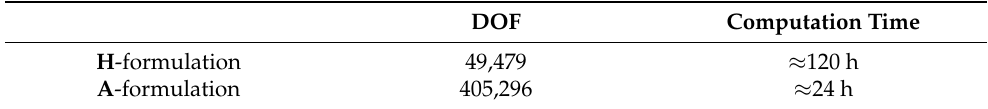
Table 1. Comparison of the mesh degree of freedom (DOF) and computation time of the models based on the H - and A -formulations, respectively.